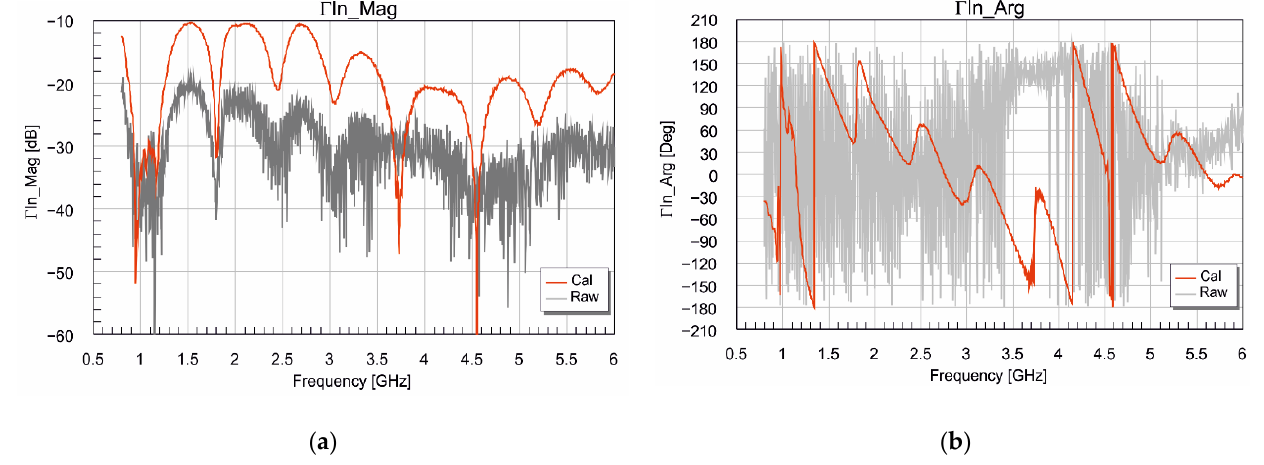
Figure 9. Reflection coefficient of the AUT: ( a ) magnitude and ( b ) phase.